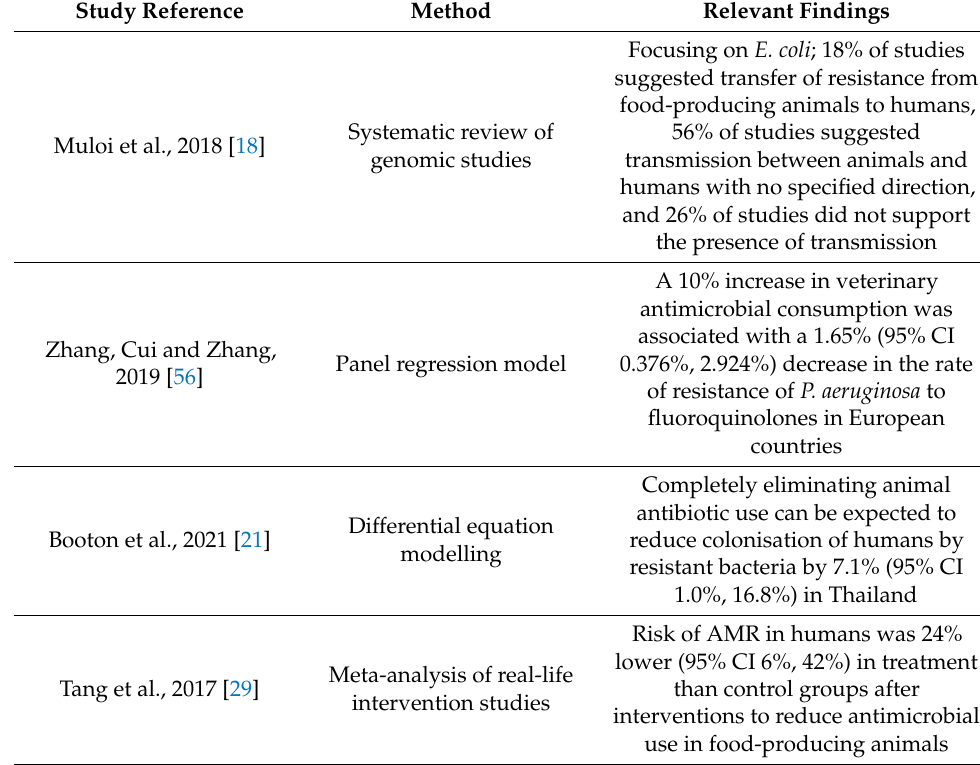
Table A1. Findings of selected studies investigating the relationship between animal AMU and human AMR.